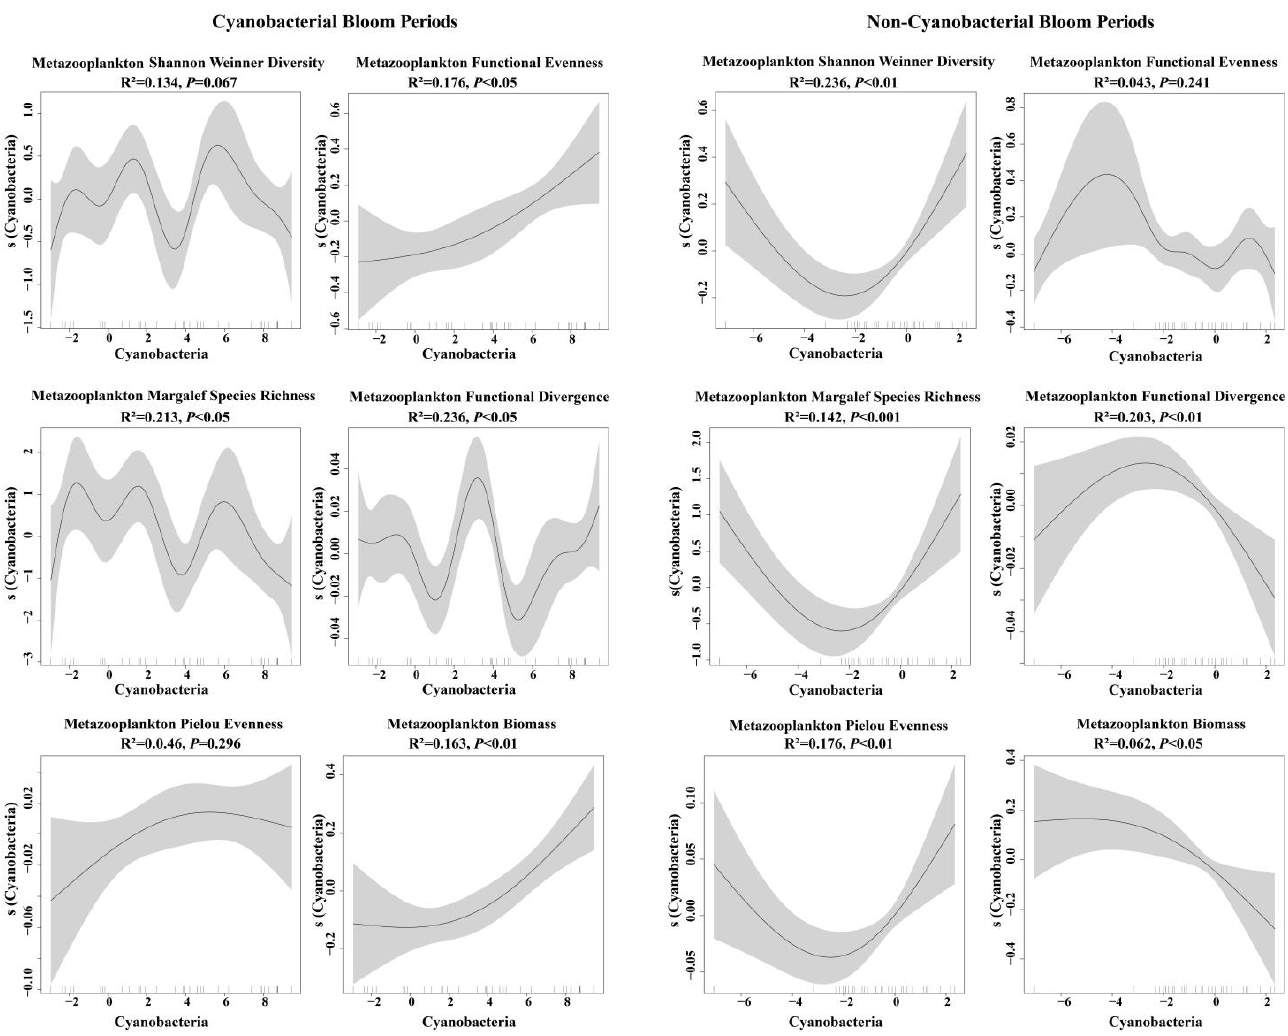
Figure 4. Models (GAMM) were mixed by fitted generalized additive to estimate effects of cyanobacteria on metazooplankton (including species diversity, functional diversity metrics, and biomass) during cyanobacterial bloom and non-bloom periods in the LXK basin ( n = 34). Explanatory variable (cyanobacteria abundance) was fixed, other factors were considered as random influencing factors.